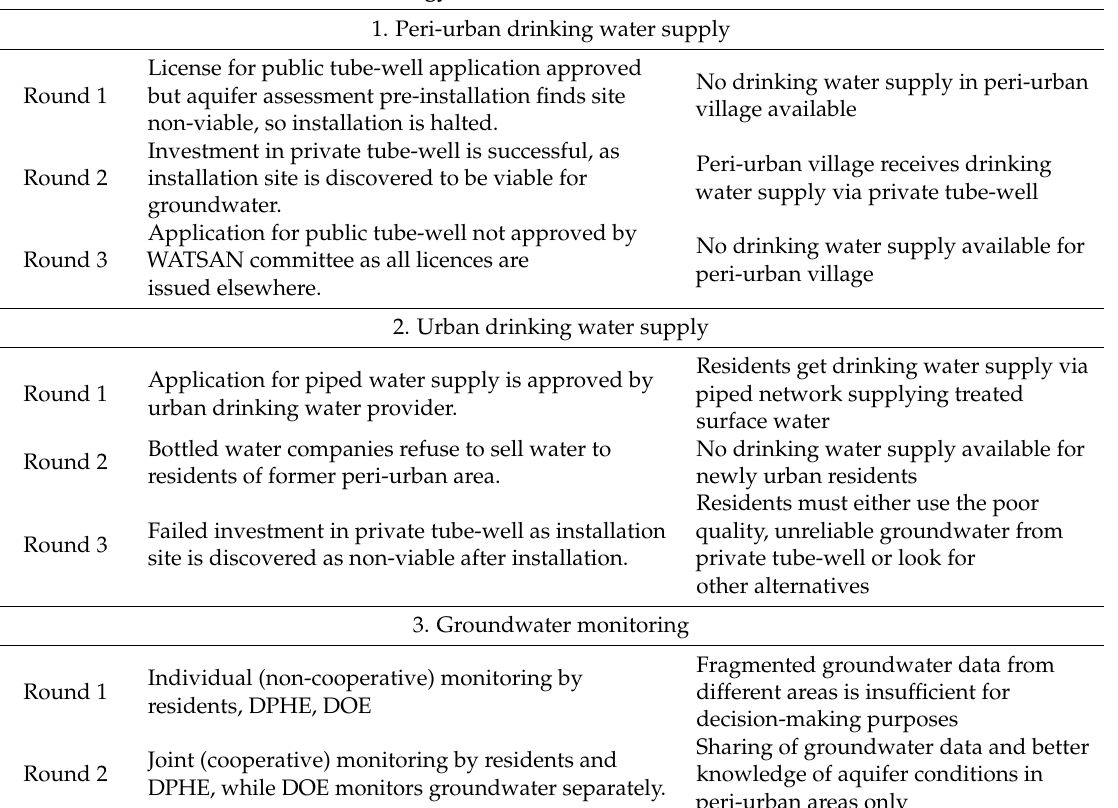
Table 1. Overview of strategies explored during the three